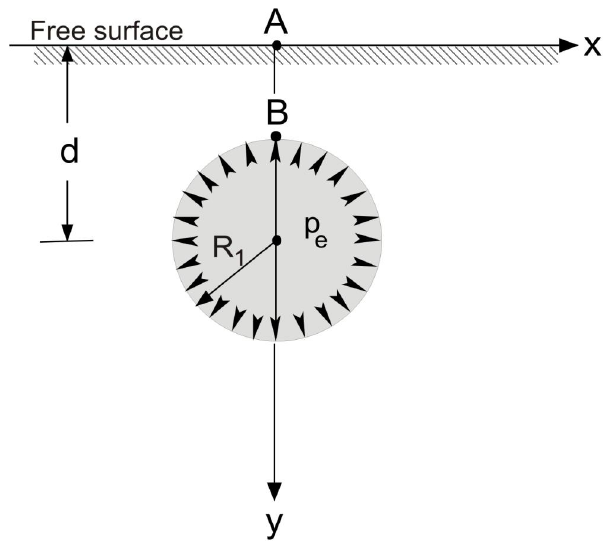
Fig. 11. Totally fluid, spherical magma chamber, the depth to its center being denoted by d . The chamber radius is R 1 , and it is sub- ject to magmatic excess pressure p e as the only loading. The point directly above the center of the magma chamber A would be the location of fissure eruptions in case the chamber rupture was at point B . Many spherical chambers, and chambers of other geometries, rupture and inject dikes and inclined sheets along their entire upper boundaries (cf. Gudmundsson, 2006).